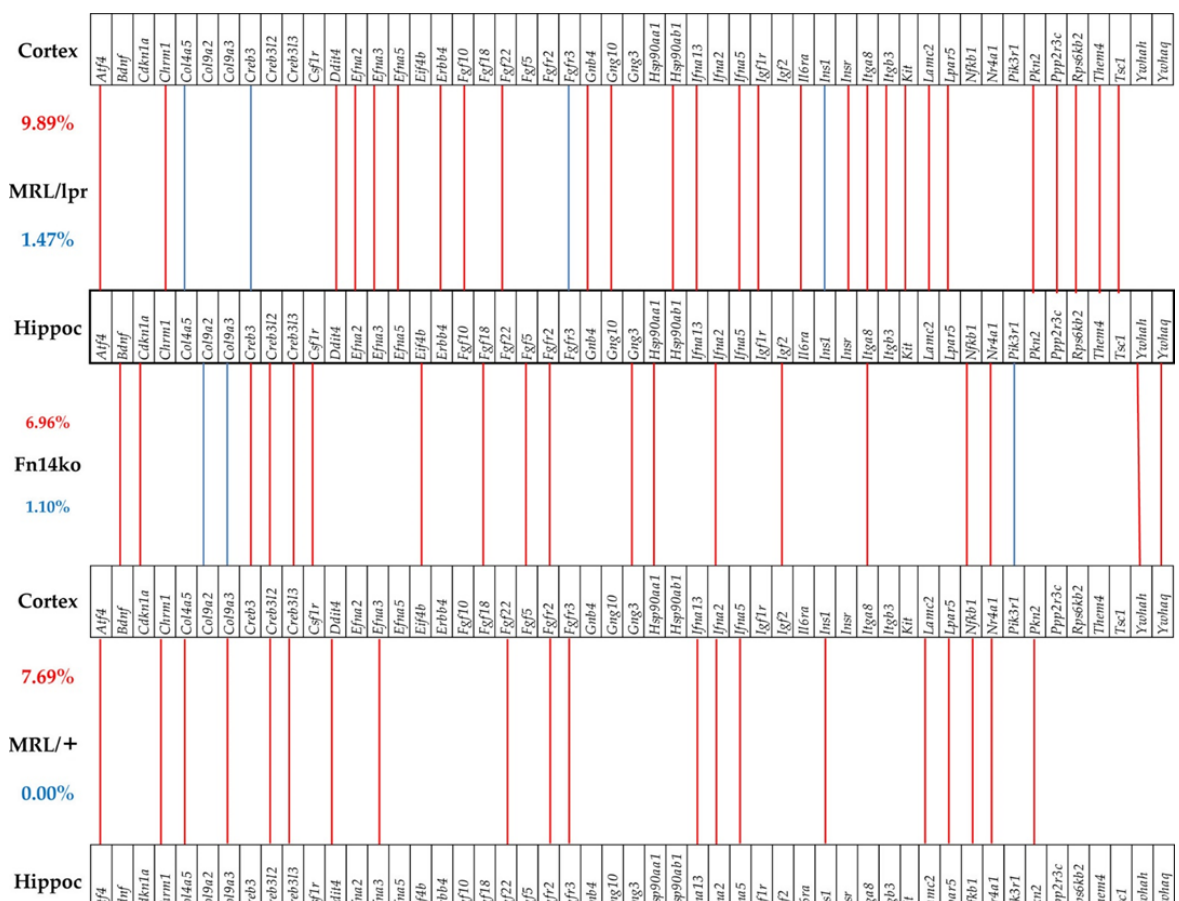
Figure 5 . Significant in-phase and anti-phase expression of PI3K-AKT genes between the cortex and hippocampus in each phenotype. Red/blue lines indicate the genes that are significantly expressed in-phase and anti-phase between the two regions. Red numbers indicate percentages of in-phase expression, and blue numbers indicate percentages of anti-phase expression.